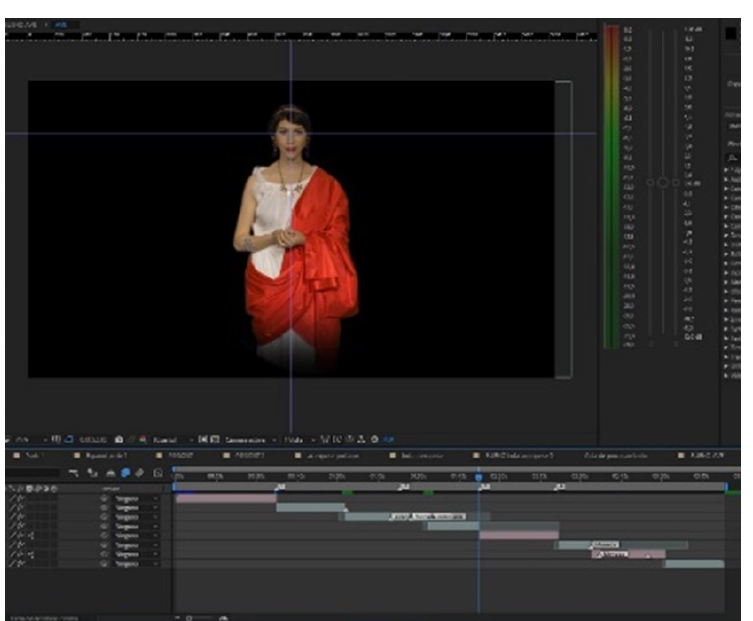
Figure 8. Post-production: adding effects with Adobe After Effects CC